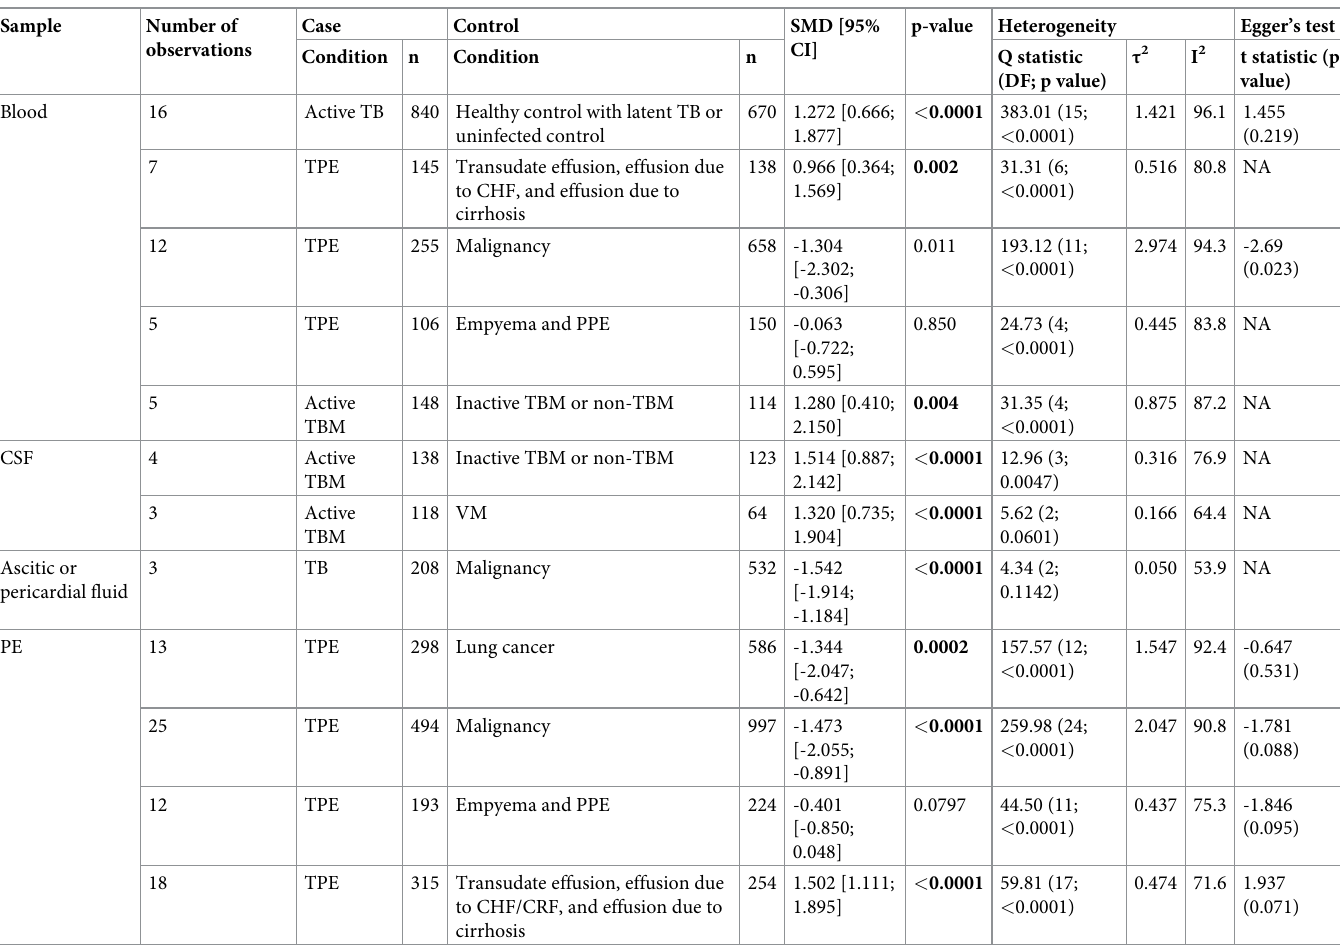
Table 1. Meta-analyses of VEGF in TB.